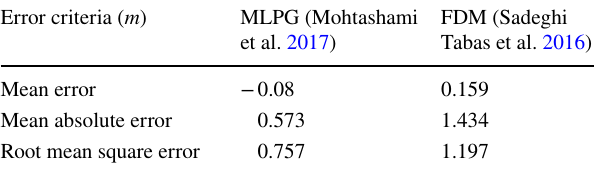
Fig. 5 Scattering nodes in Birjand aquifer Table 2 Computation of error indices in unsteady state Error criteria ( m )